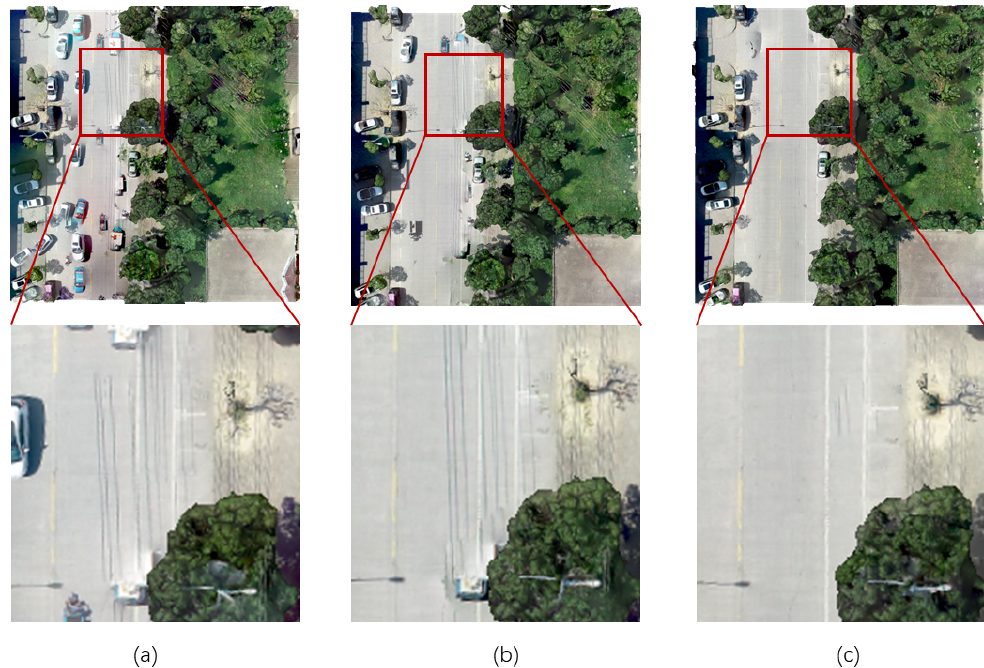
Figure 6. Comparison of texture-mapping results of the road wires of in dataset TJH-0078. ( a ) results of experiments without image consistency detection; ( b ) results of the method of mvs-texturing; and ( c ) results of our method.